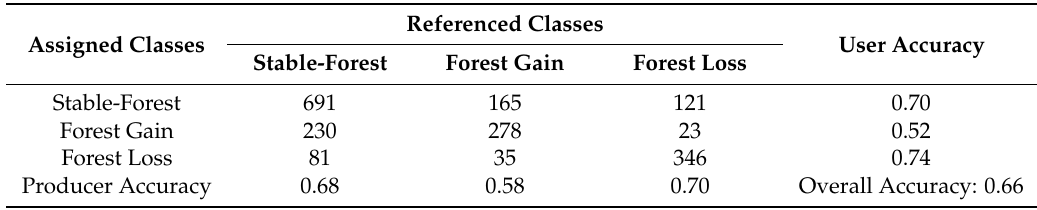
Table 5. Confusion matrix for the forest dynamics map.